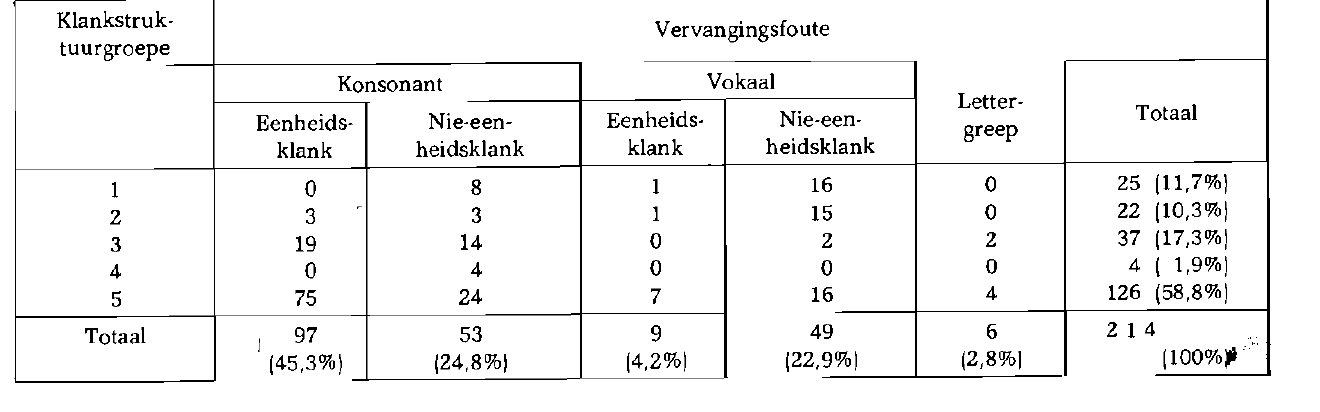
Tabel 1: Vervangingsfoute by die verskillende klankstruktuurgroepe: